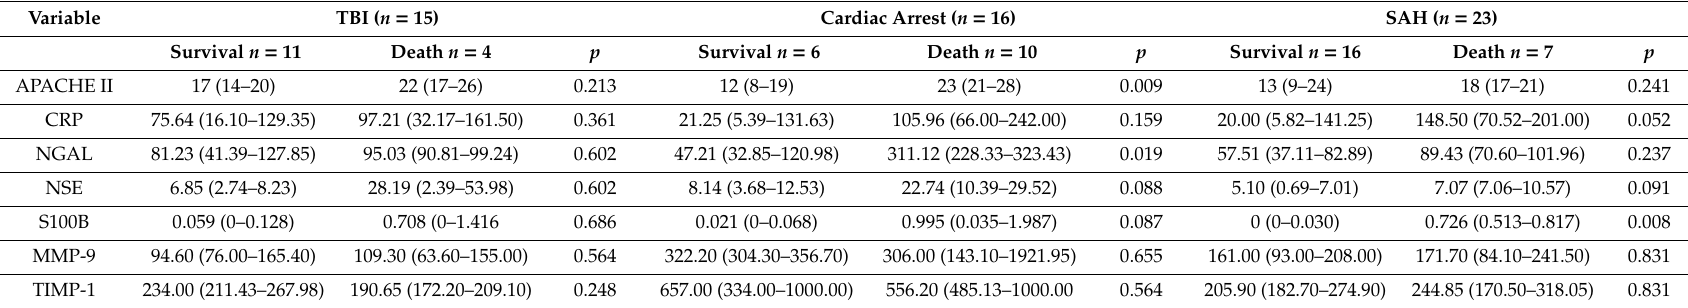
Table 3. Concentrations of studied biomarkers assessed in deceased patients and survivors in subgroup analyses in patients with traumatic brain injury (TBI), subarachnoid hemorrhage (SAH), and post-cardiac arrest syndrome 1